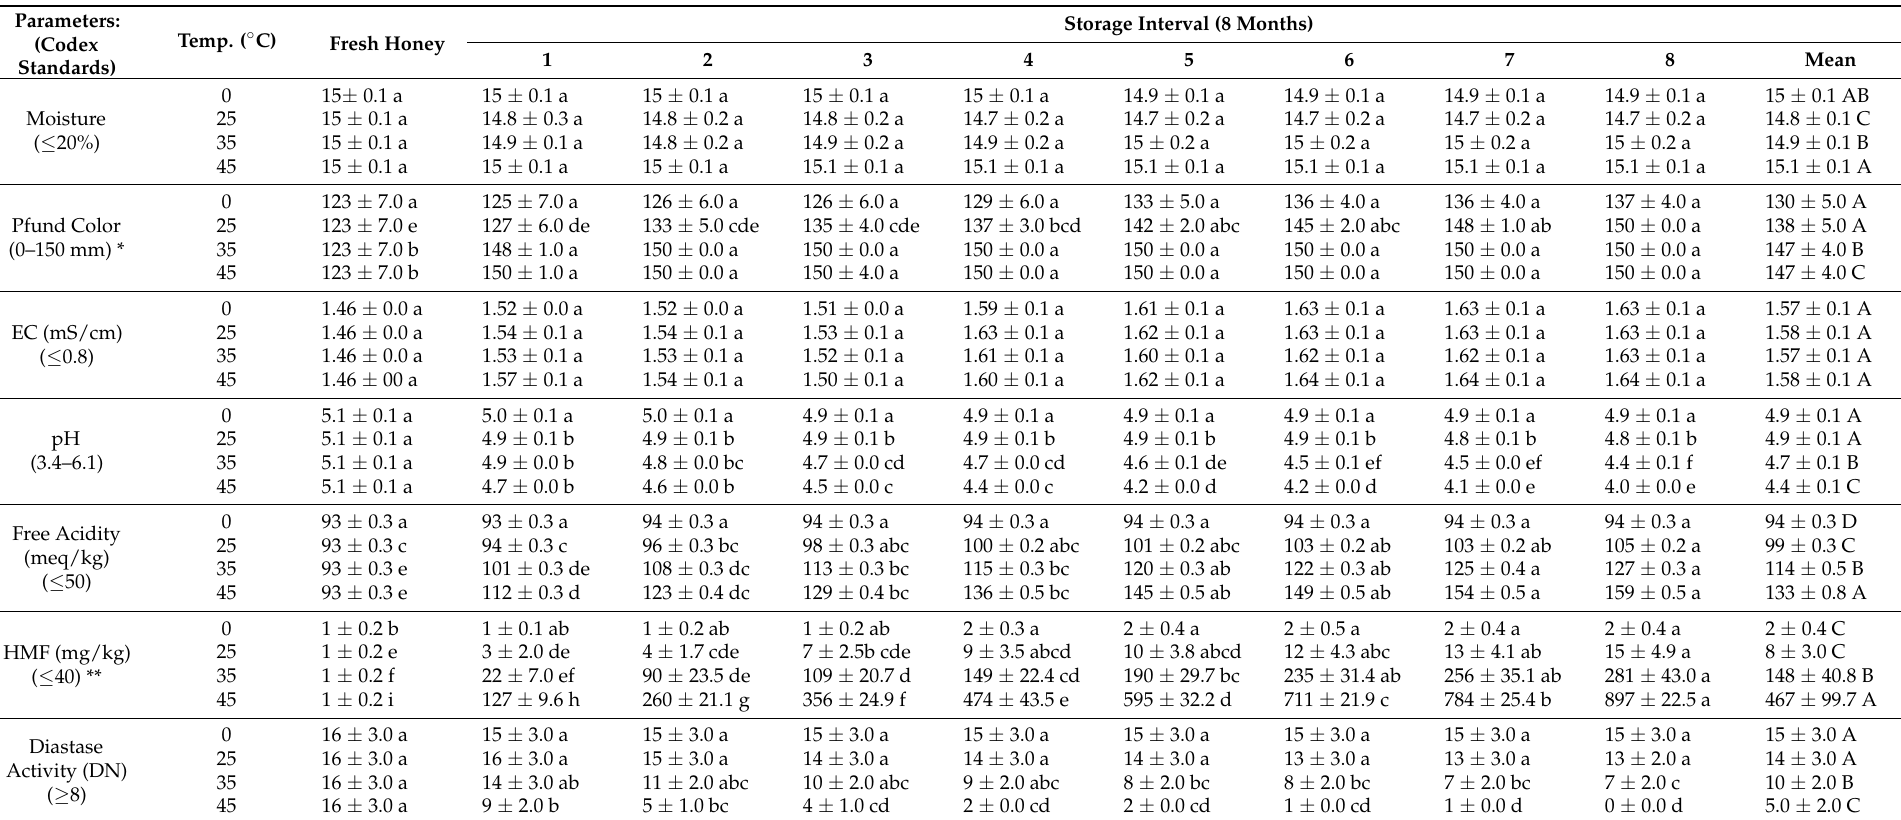
Table 2. Physicochemical analysis of Talh Acacia gerrardii honey according to different temperatures and storage intervals for eight months from